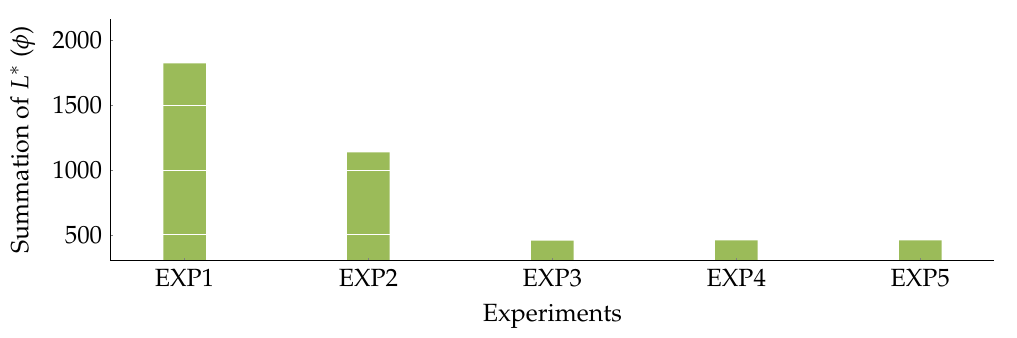
Figure 7. The effects of varying SyncLimit on the network